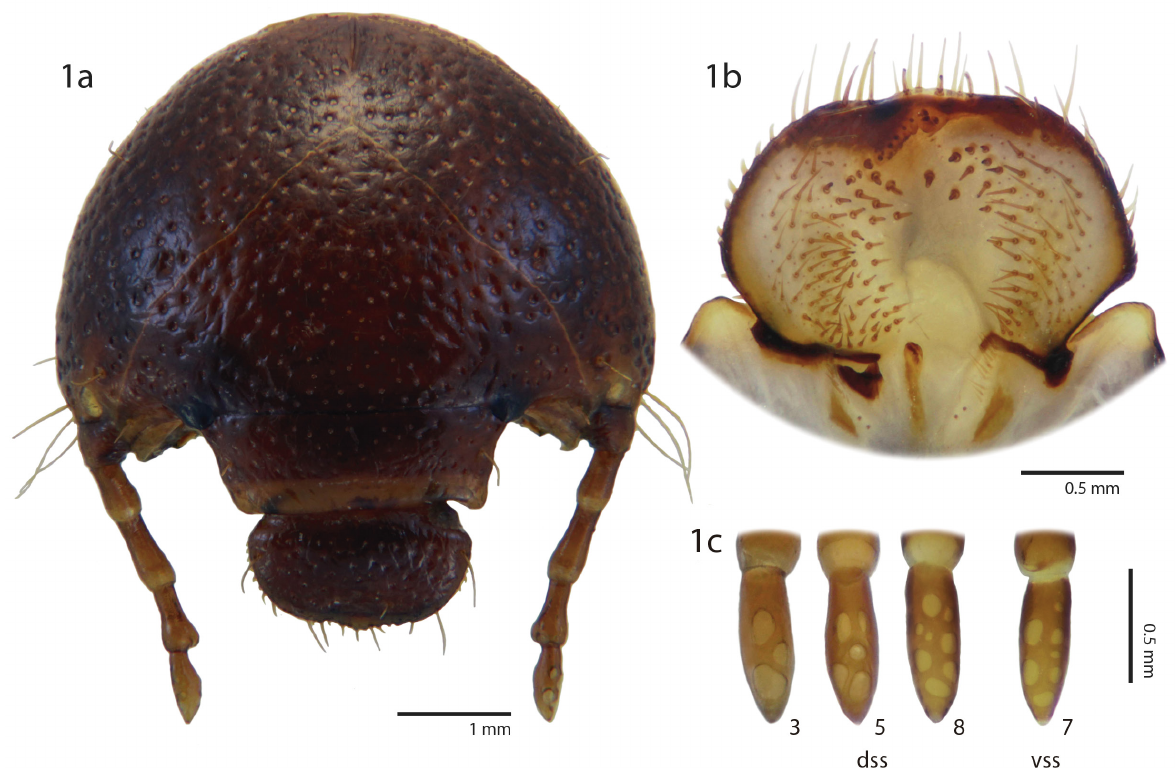
Figure 1. Stenocrates agricola , third instar. Head and antenna (a–c). (a) Cranium in frontal view. (b) Epipharynx. (c) Terminal segment of antenna with three, five, and eight dorsal sensory spots (dss) and with seven ventral sensory spots